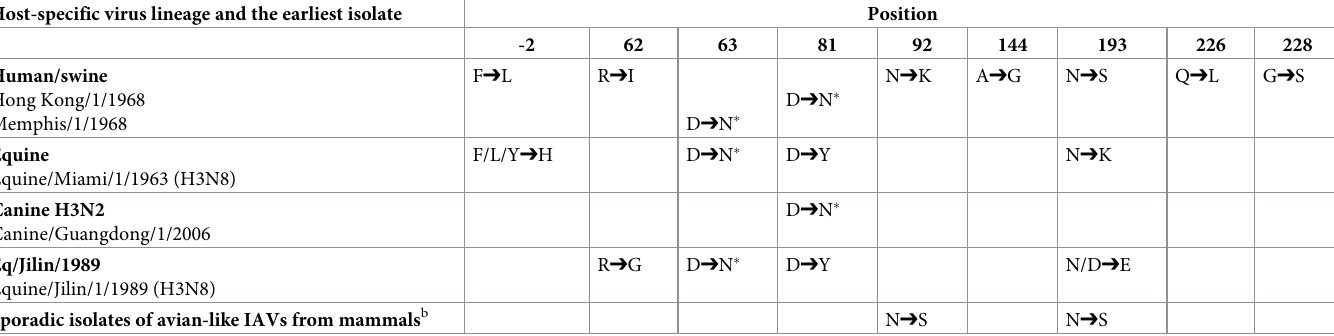
Table 2. Alteration of amino acids at 9 positions of the H3 HA during host shifts a . Host-specific virus lineage and the earliest isolate